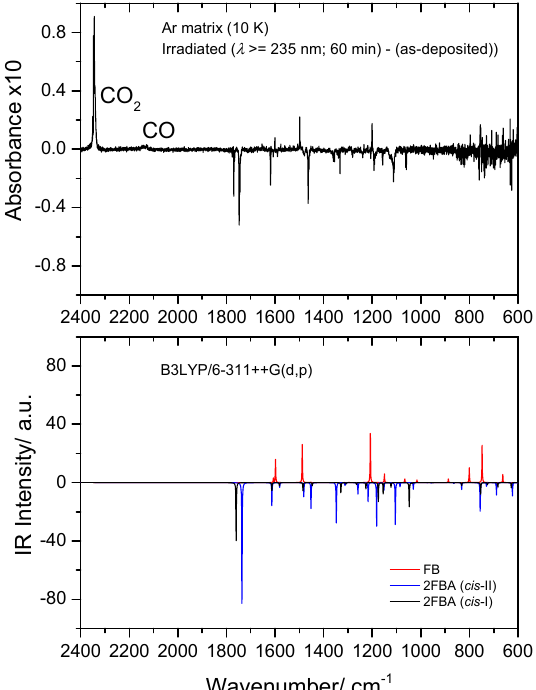
Figure 15. Top : 2400–600 cm –1 region of the difference IR spectrum: irradiated Ar matrix of 2-fluorobenzoic acid (2FBA) minus as-deposited matrix. Bottom: Simulated difference spectrum based on the B3LYP/6-311++G(d,p) calculated IR spectra of 2FBA ( cis -I and cis -II conformers; bands pointing down) and the observed photoproducts: CO 2 , CO, and fluorobenzene (FB) (bands pointing up). The calculated wavenumbers were scaled by 0.978, and the calculated intensities were multiplied by arbitrary factors in order to fit better the observed spectrum (in a ratio of ~2:1:3, 2FBA cis -II:2FBA cis -II:FB).